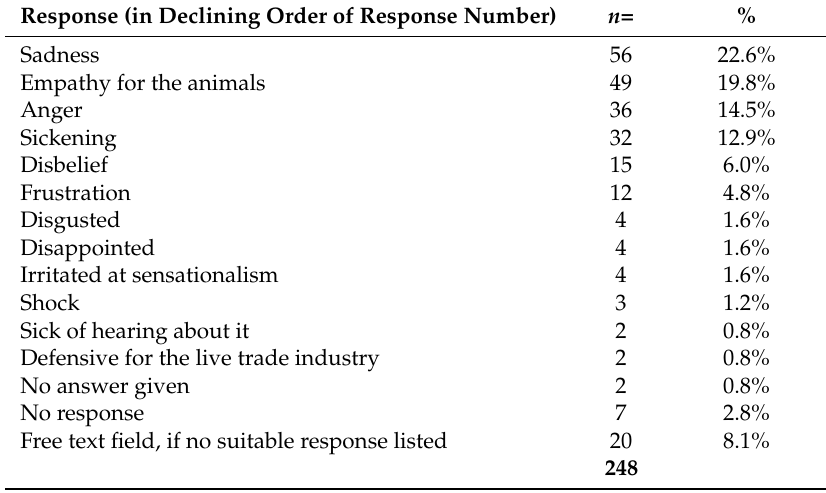
Table 4. Responses to questions about how respondents * felt about the live export trade in surveys conducted before and after a media event about live export.